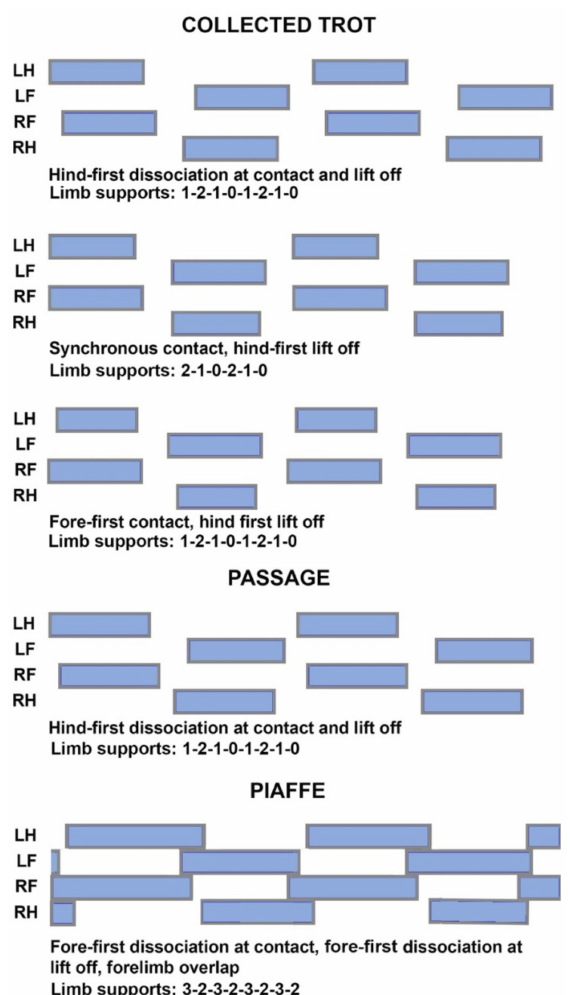
Figure 2. Common limb support sequences for collected trot ( top 3 diagrams ), passage ( middle diagram ) and pia ff e ( bottom diagram ). Limb support sequences other than those shown do occur, especially in pia ff e. LH: left hind limb; RH: right hind limb; LF: left forelimb; RF: right forelimb.